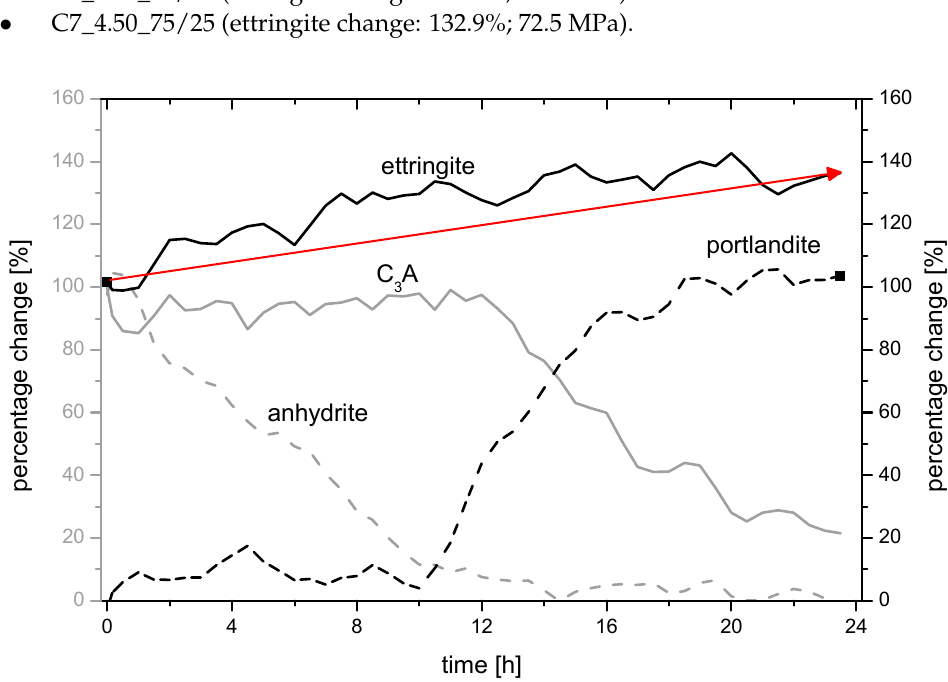
Figure 8. In ‐ situ XRD ‐ measurement of the mpc for different phases in sample C7_4.50_25/75.